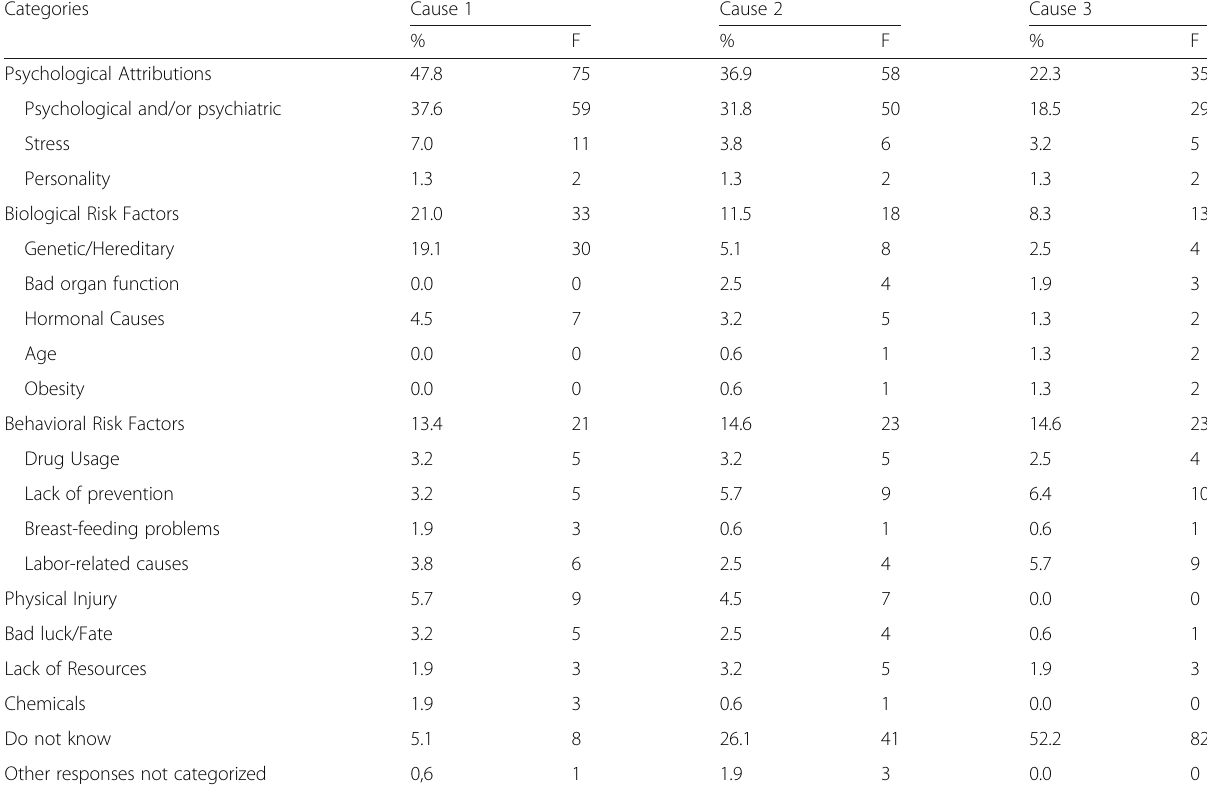
Table 3 Percentage and Frequency of Spontaneous Answers according to categories and subcategories of Breast Cancer Causal Attribution ( N =